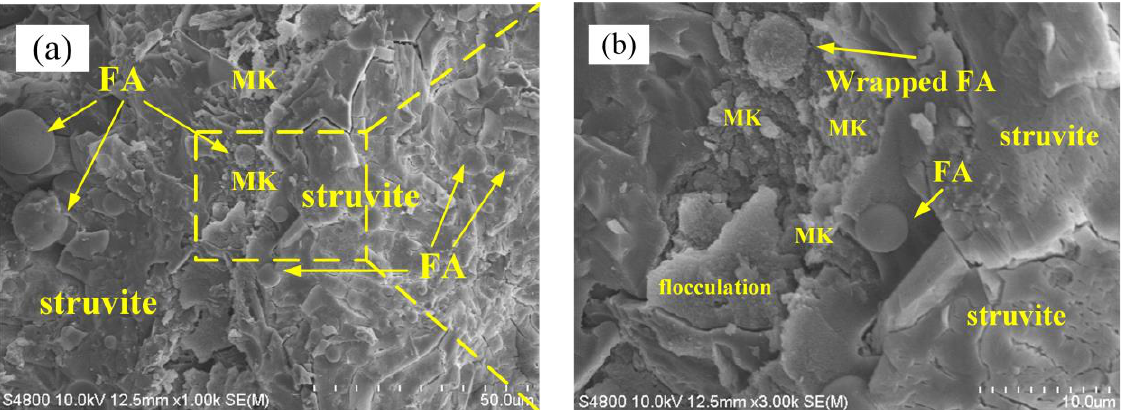
Figure 24. SEM images of the MPC pastes containing FA and MK at 28 d: ( a ) 1000 magnification, ( b ) 3000